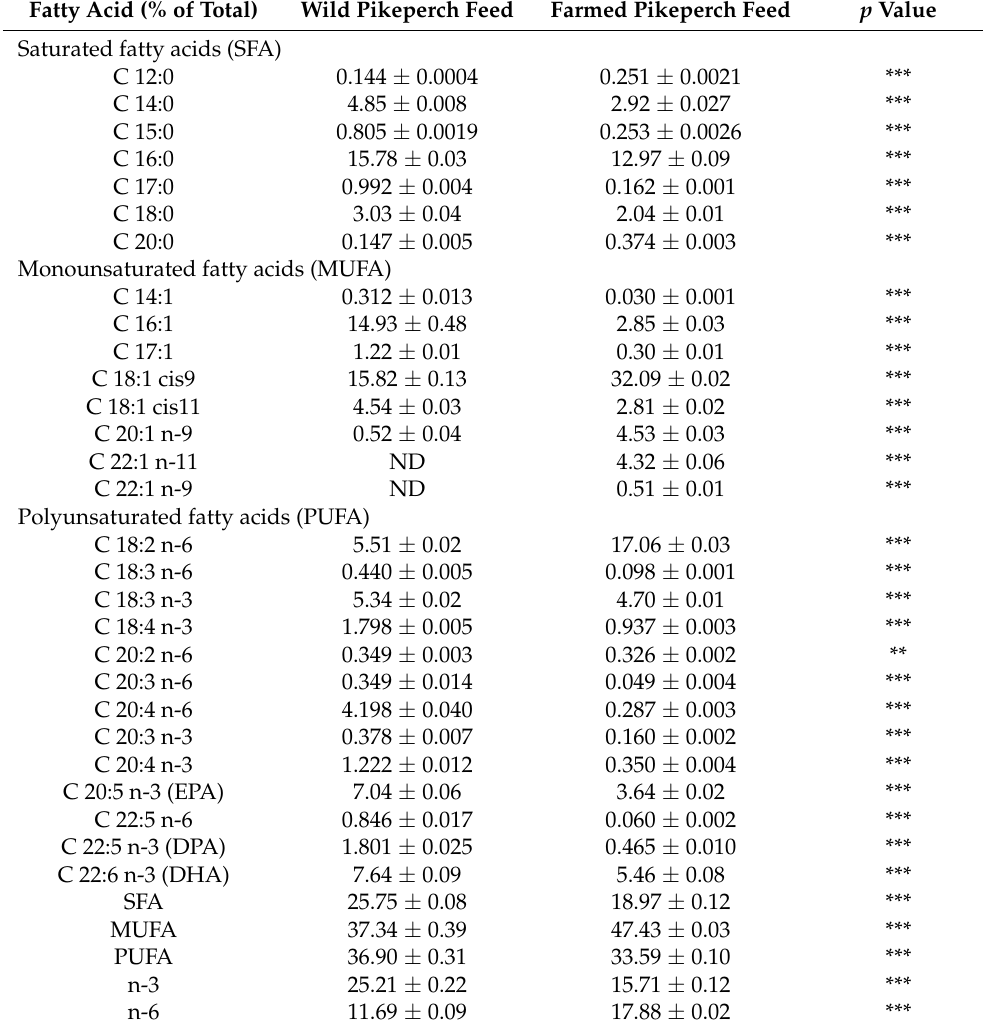
Table 2. Fatty acid composition of wild ( n = 3) and farmed ( n = 3) pikeperch feed (mean values ± stan- dard error). Fatty Acid (% of Total) Wild Pikeperch Feed Farmed Pikeperch Feed Saturated fatty acids